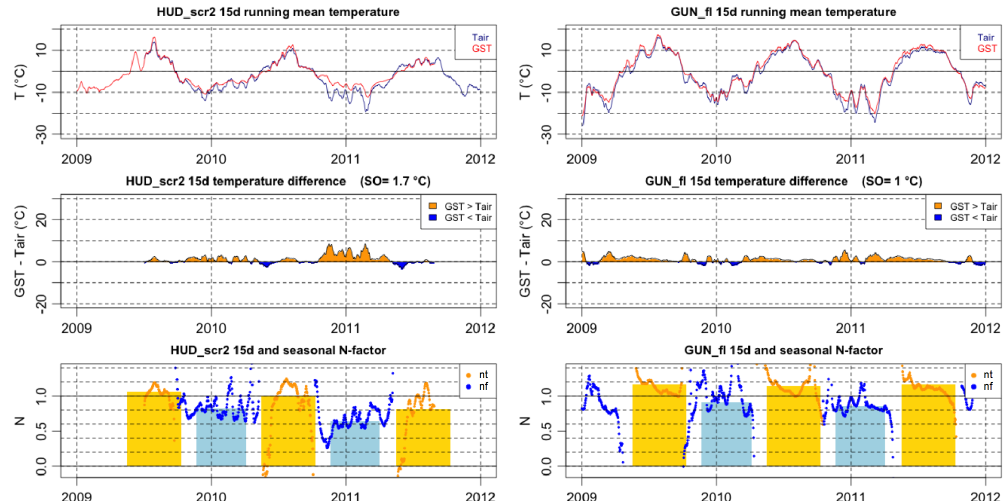
Figure 7. Seasonal development of temperature differences and N factors in a windy scree slope at Hudson Bay Mountain (left) and on a windy plateau at Mount Gunnel (right). Top: air and ground-surface temperature (15-day running mean); middle: temperature difference (GST– T air ) on 15-day running average; bottom: N factors on seasonal average (bars) and 15-day average (points). Note that the 2009 and 2011 seasonal thawing N factors ( nt ) at HUD_scr2 are slightly biased by the incomplete data. At both sites GST follows the air temperature. The snow cover is slightly more developed at HUD_scr2 and reduces both freezing and thawing N factors.